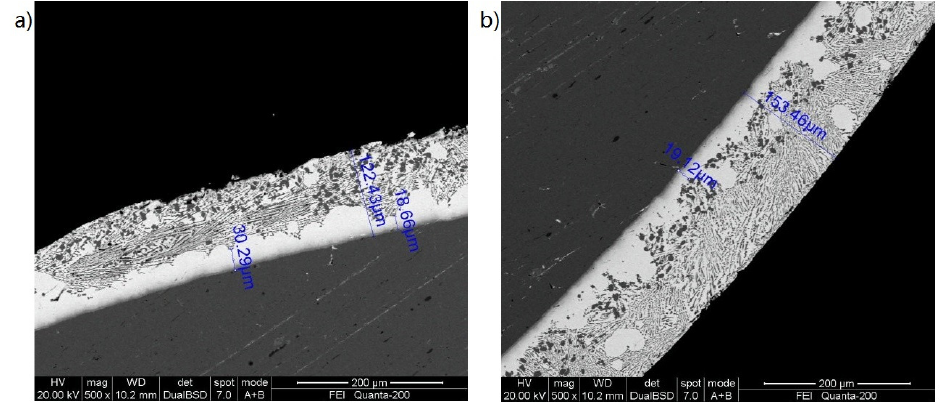
Figure 10. Cross-sectional SEM morphologies of the sintered cylinder at temperature of 395 °C ( a ) and 430 °C ( b ).